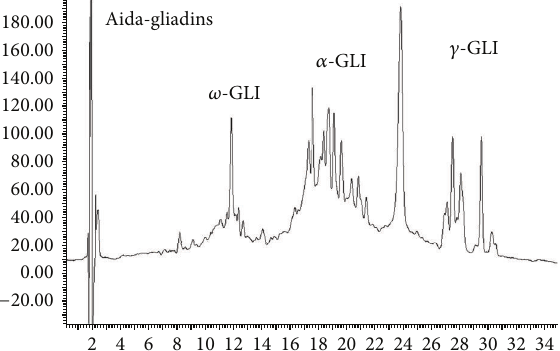
Figure 4: Chromatogram of gliadins of cultivar